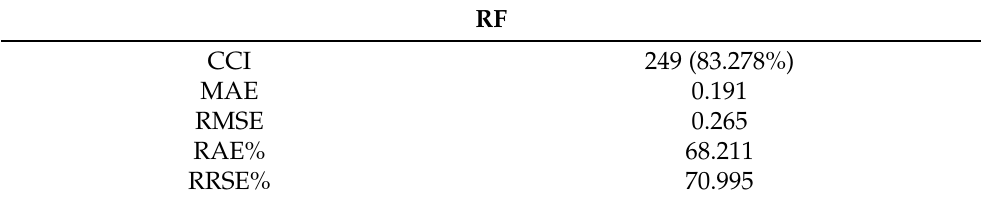
Table 23. CCI and Error Rates details achieved via RF.